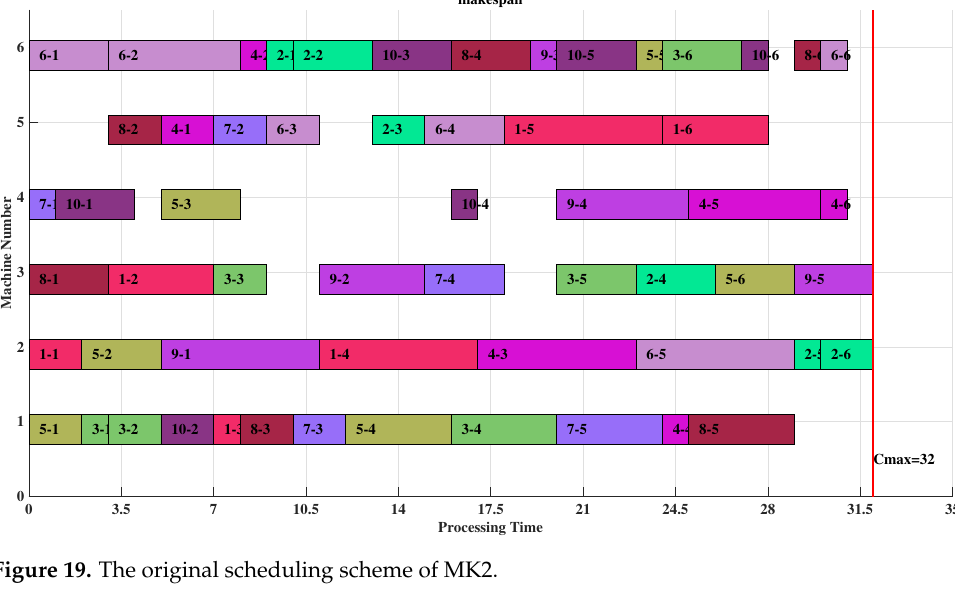
Figure 19. The original scheduling scheme of MK2.